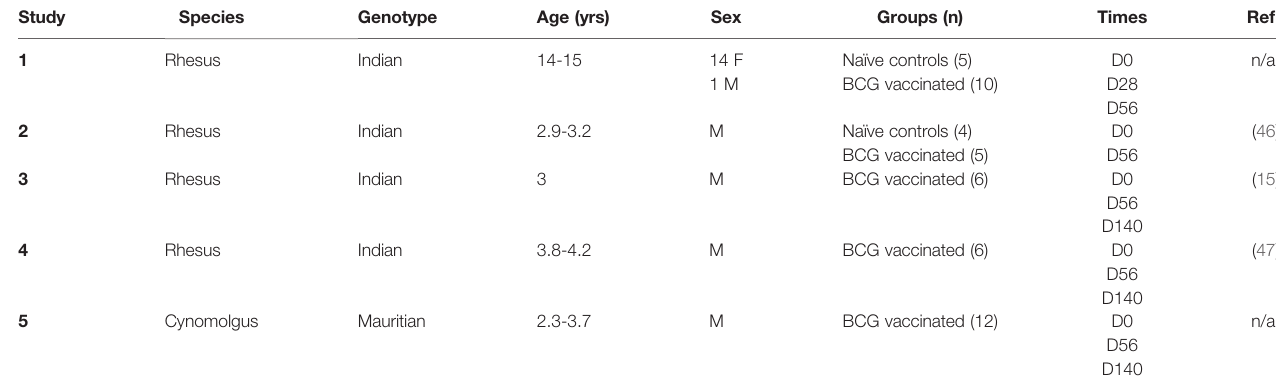
TABLE 1 | Summary of macaque samples used in antibody